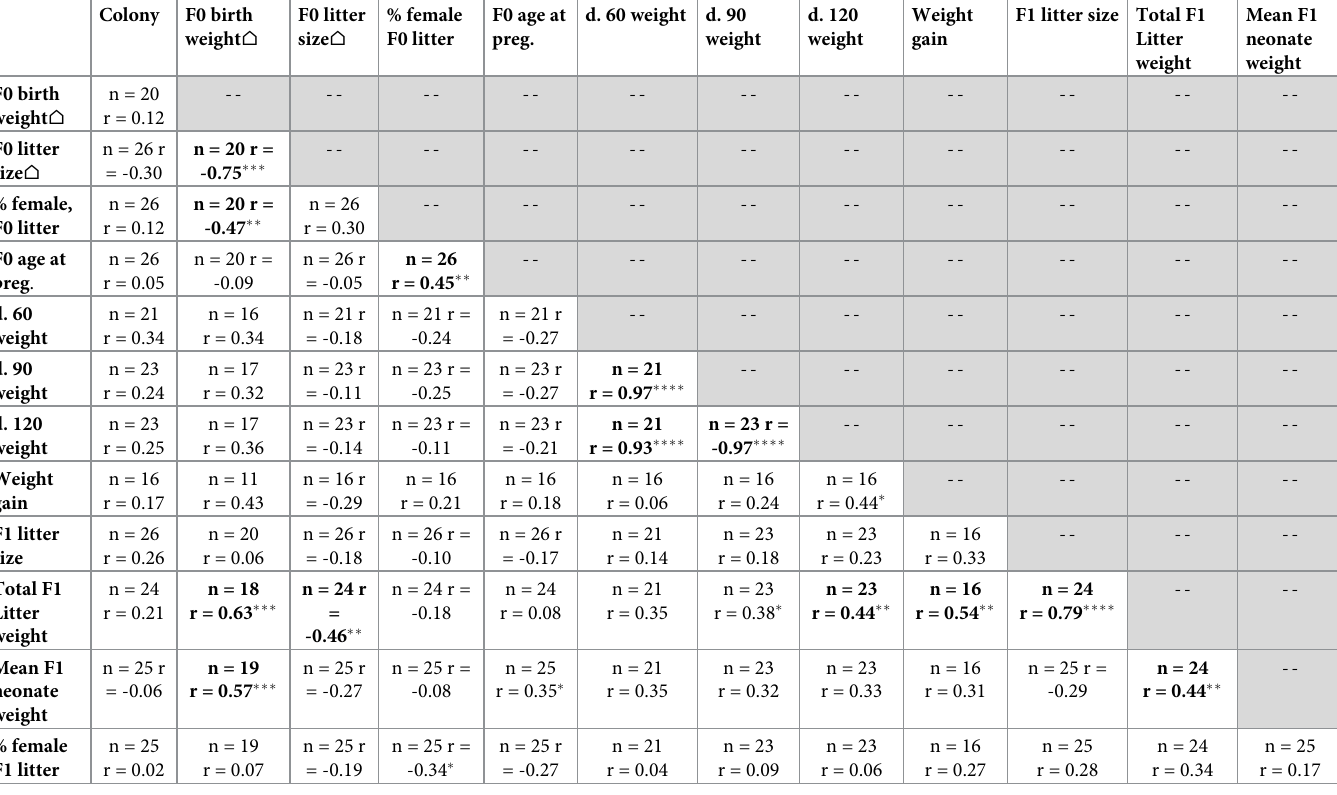
Table 2. Correlation matrix of predictor